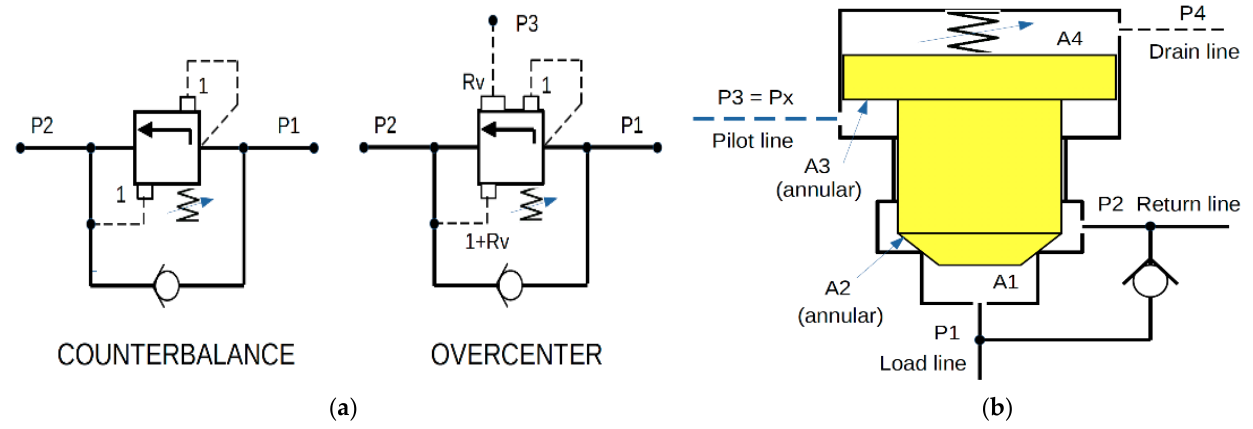
Figure 1. The traditional principle of pressure – spring load-holding valve model. ( a ) ISO 1219 symbols; ( b ) Functional scheme of the load holding valve, LHV.